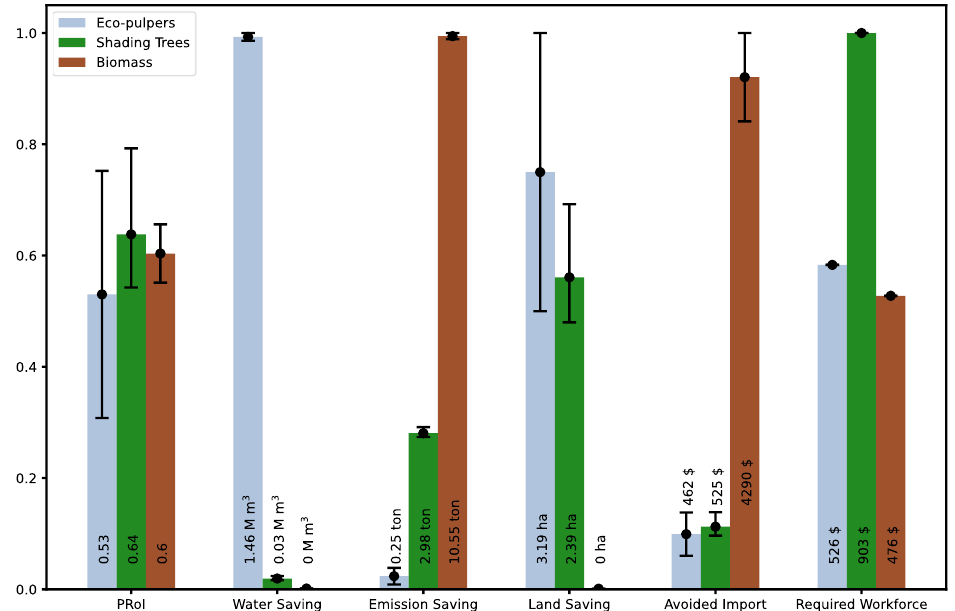
Figure 5. Comparison between performance indicators representing the net yearly gain from every intervention assuming the same level of investment (i.e., KES 1 million corresponding to nearly $9k) in average scenarios (bar height). The end of the scale corresponds to the highest value among the considered options within the sensitivity cases (error bars), while PRoI is expressed as defined in Equation (3) using KES 1 million as the denominator. MCM stands for million cubic meters.